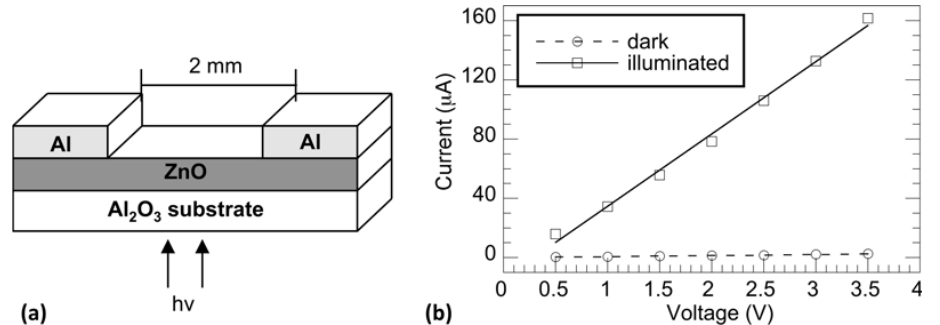
Figure 2. ( a ) Schematic diagram of the Al:ZnO:Al MSM planar structure; and ( b ) IV curves in dark and UV illumination for a photodetector annealed at 573 K. Illumination was via a deuterium lamp reactor with an intensity at the detector of 2 mW/cm 2